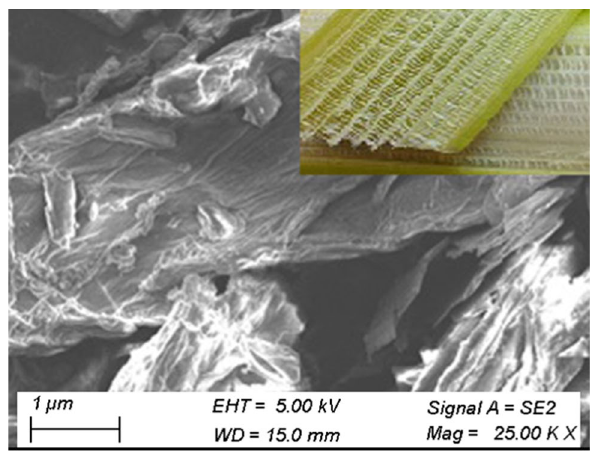
Fig. 2 SEM spectrum of pseudo-stem banana fiber and original banana fiber (inset)